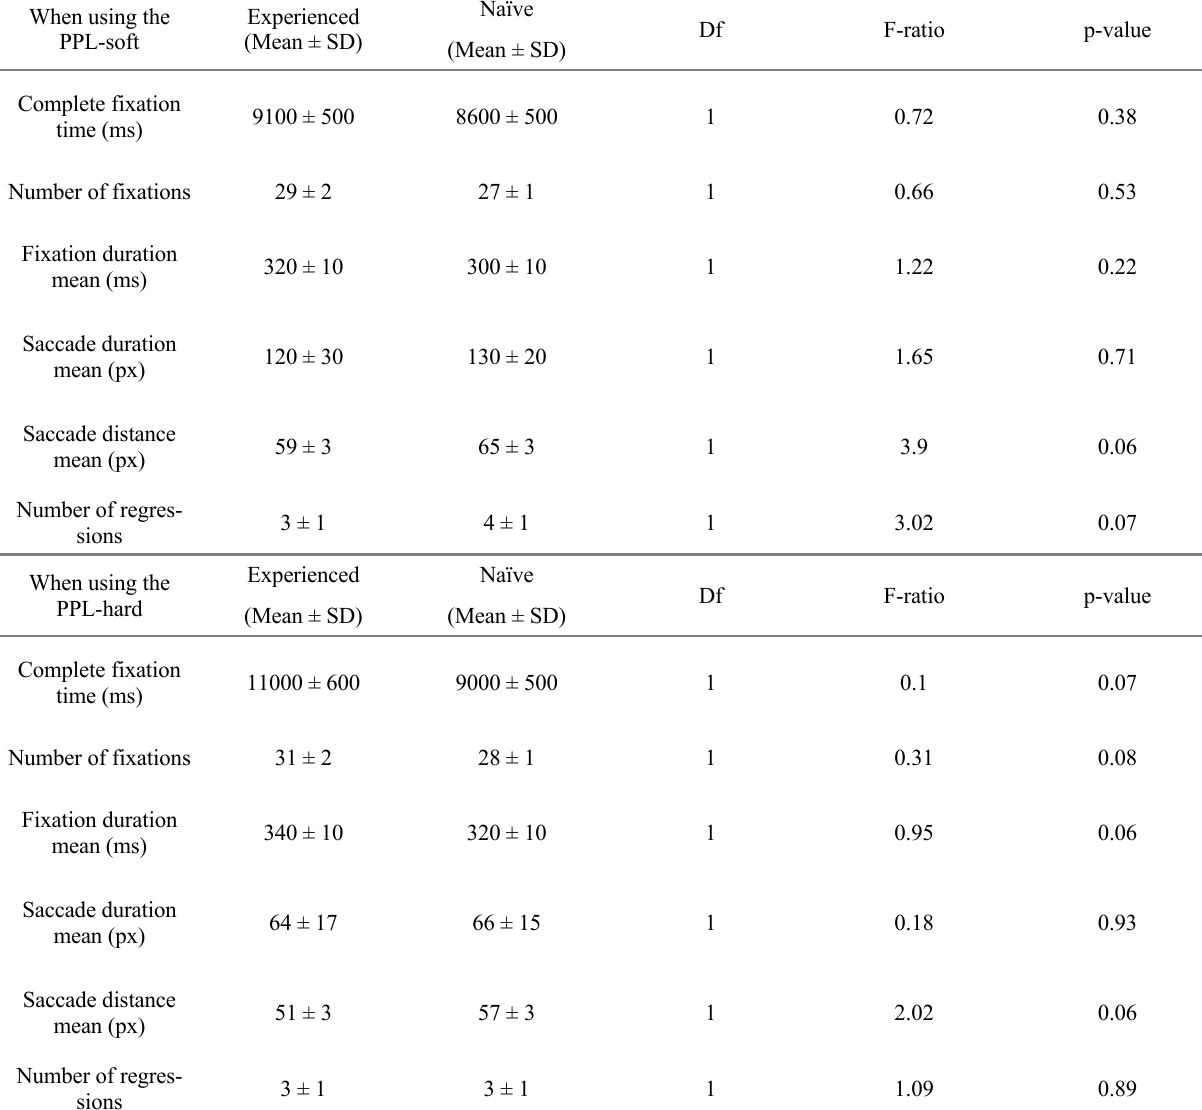
Table 2. EM differences according to the subjects’ PPL experience when subjects were using PPL-soft and PPL-hard. Statistical significance p<0.05, randomized complete block